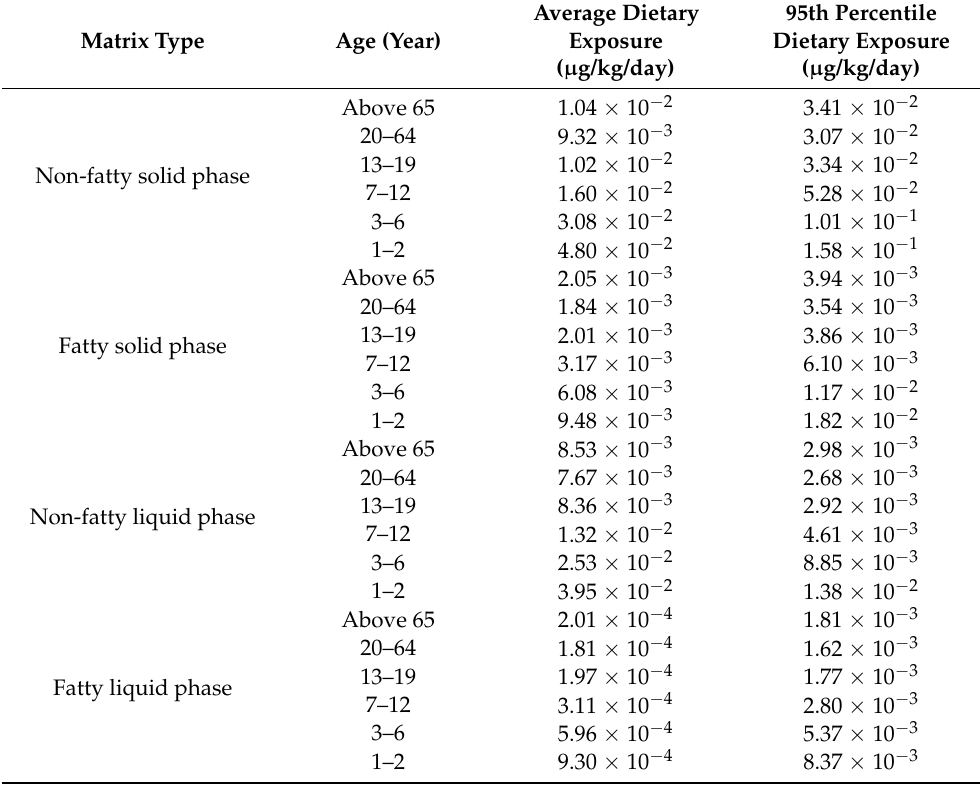
Table 6. CDI of the six heavy metals in non-fatty solid phase, fatty solid phase, non-fatty liquid phase and fatty liquid phases of